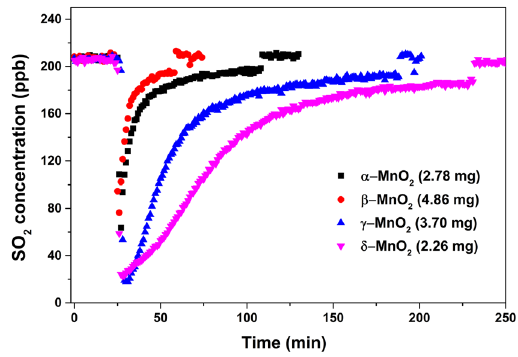
Figure 5. Uptake curves of SO 2 on different crystal manganese